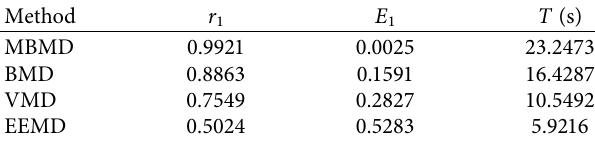
Figure 6: The decomposition result of x ( t ) generated by EEMD. Table 2: Evaluation parameters of decomposition